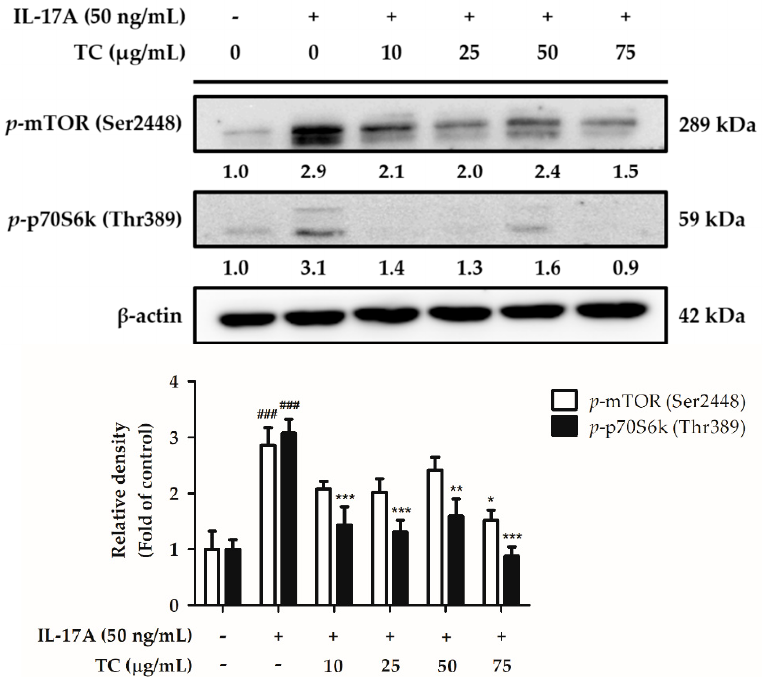
Figure 9. TC suppresses IL-17A-induced cell proliferation in human keratinocytes via the p -mTOR/ p -p70S6k signaling pathway. TC could inhibit IL-17A-induced p -mTOR and p -p70S6k expression in human keratinocytes, thereby possibly suppressing excess activation of the cell proliferation pathway. Significant differences between treated groups were evaluated. ### p < 0.001 compared to the control group. * p < 0.05; ** p < 0.01; *** p < 0.001 compared to the IL-17A-induced group.